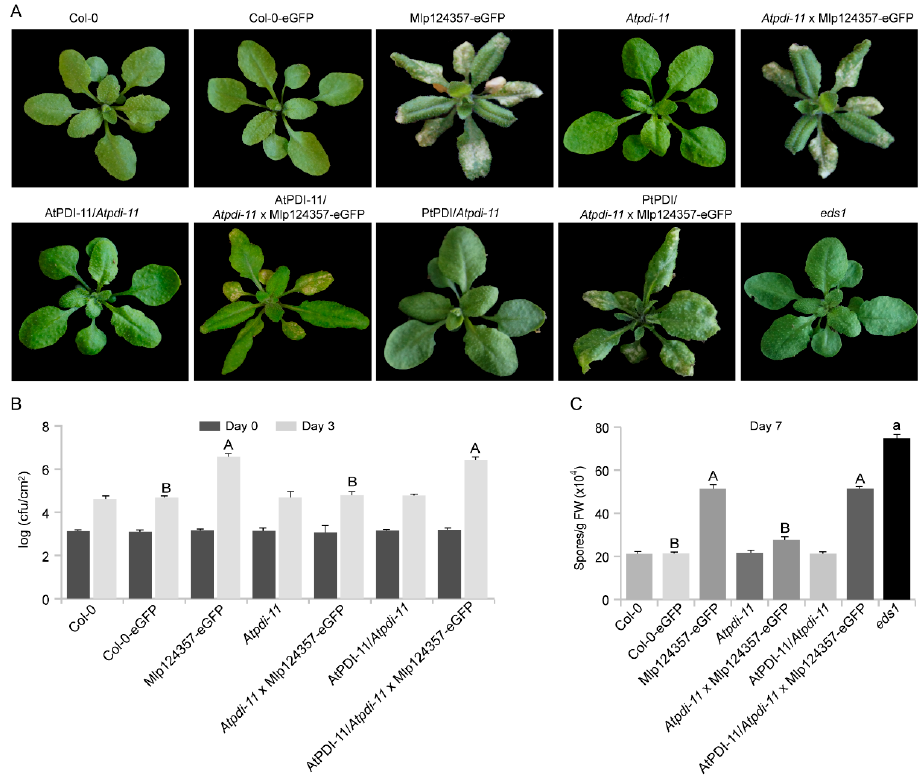
Figure 7. PDI-11 is not involved in plant immunity. ( A ) Morphology of each genotype that were used for the infection assays. Photographs were taken from 4-week-old soil-grown plants. ( B ) Growth of PstDC3000 bacteria in Arabidopsis . One-way ANOVA ( p < 0.05) with Tukey’s test was performed to compare genotypes with GFP or without GFP. There was no difference between genotype without GFP. Different letters indicate statistically significant difference between Col-0-eGFP, Mlp124357-eGFP, Atpdi-11 x Mlp124357-eGFP, and AtPDI-11/Atpdi-11 x Mlp124357-eGFP. For each genotype five replicates were used; cfu, colony-forming unit. ( C ) Growth of H. arabidopsidis Noco2 oomycete in Arabidopsis . For genotypes without eGFP (Col-0, Atpdi-11, AtPDI-11/Atpdi-11, and eds1 ), significance was evaluated using ANOVA ( p < 0.05) with Tukey’s. For genotypes with eGFP (Col-0-eGFP, Mlp124357-eGFP, Atpdi-11 × Mlp124357-eGFP and AtPDI-11/Atpdi-11 × Mlp124357-eGFP) significance was evaluated using ANOVA ( p < 0.05, different capital letters denote significant difference) with Tukey’s test. FW, fresh weight. Both bacterial and oomycete infection experiments were repeated at least three times and representative data are shown.